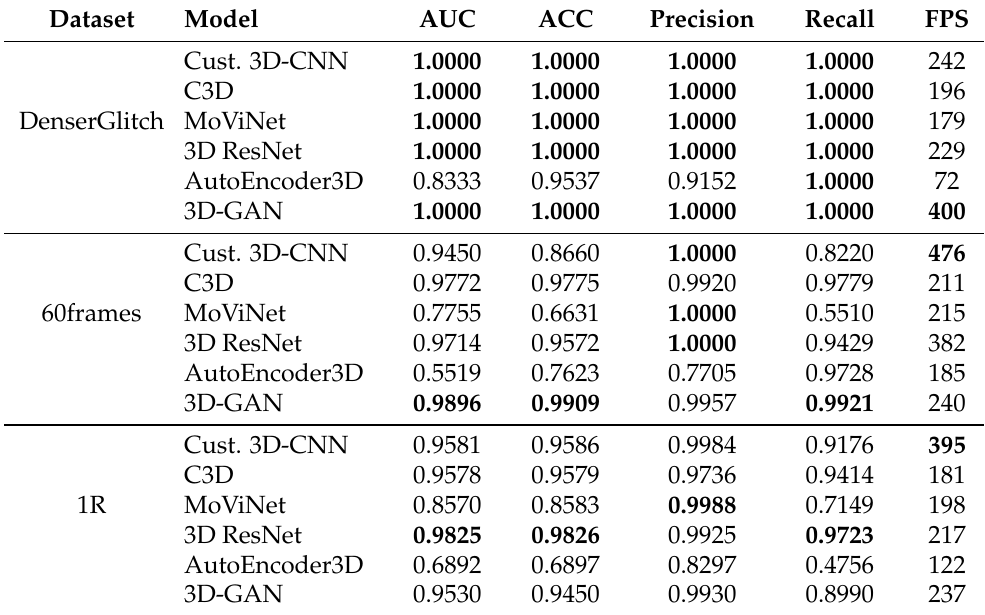
Table 3. Comparison among the six deep learning 3D methods experimented upon three